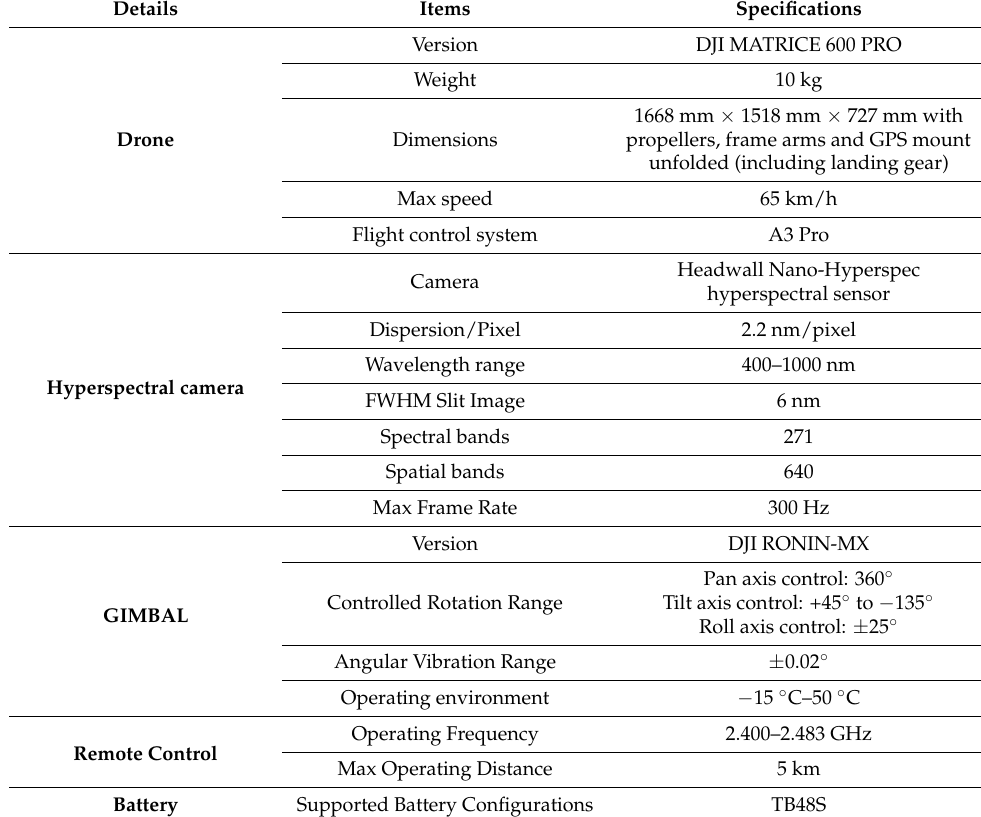
Figure 1. Overview of the study area and sampling: ( a ) application of the UAV; ( b ) four-point method of sampling; ( c ) sample point distribution; ( d ) UAV platform and airborne hyperspectral imaging sensor; ( e ) hyperspectral imaging sensor; ( f ) Xinjiang’s position in China; ( g ) geographical location of Fukang City. Table 3. The technical specifications of the UAV.